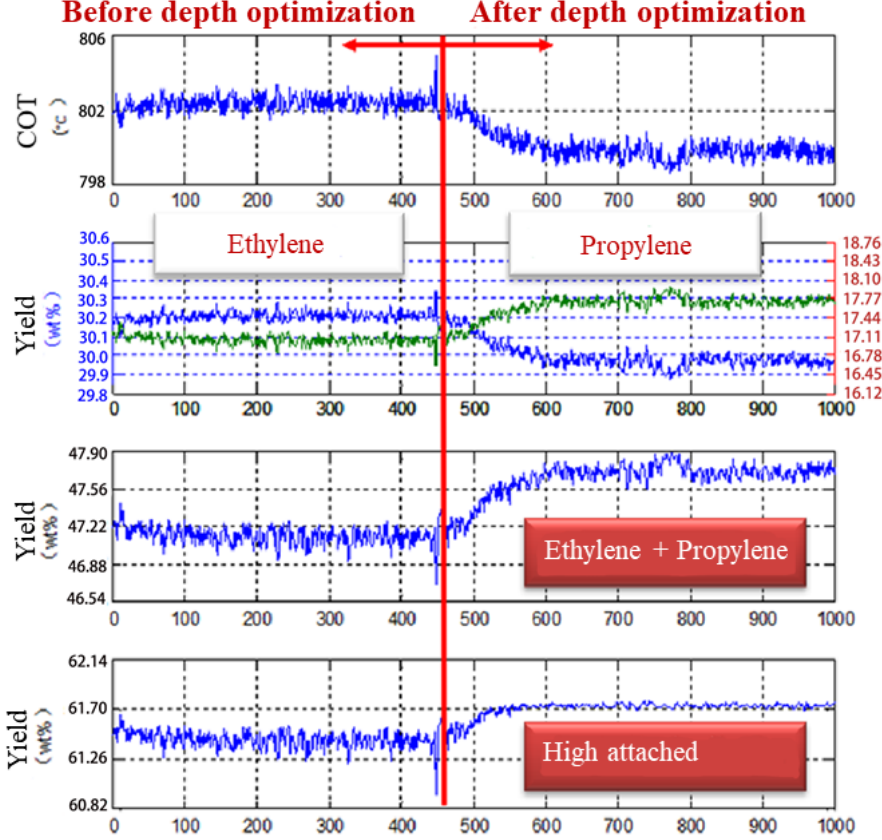
Figure 10. Effects of real-time optimization of cracking depth by combination of online analysis of ethylene cracking feed.